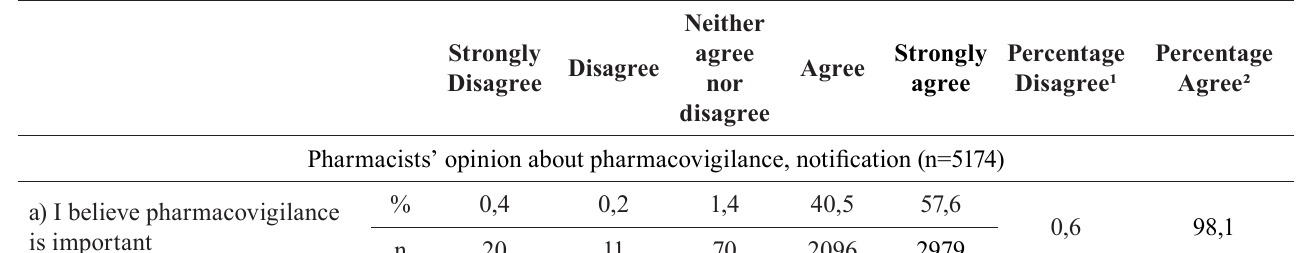
Table SI - Pharmacists’ opinion about pharmacovigilance, notification and